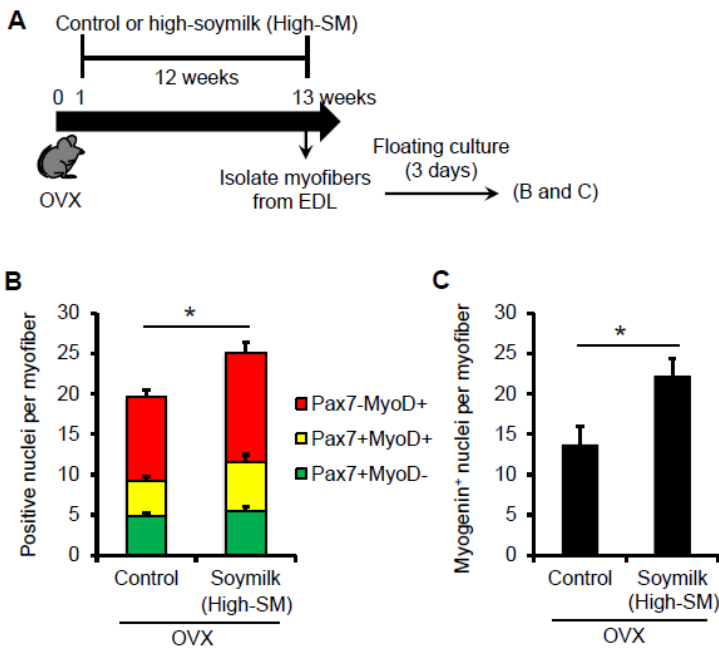
Figure 5. Effect of High ‐ SM intake on satellite cell function in OVX mice. ( A ) OVX mice were fed with High ‐ SM as shown in Figure 3. Satellite cells retained in their niche on myofibers were isolated from the extensor digitorum longus (EDL) muscle in OVX mice, cultured in mitogen ‐ rich medium for 72 h, and co ‐ immunostained for Pax7 and MyoD. Number of Pax7 + and/or MyoD + ( B ) or Myogenin + ( C ) nuclei per myofibre was quantified. (more than 20 myofibers per mouse were counted; control, n = 5; soymilk, n = 4 mice). Data represent the mean ± SEM. n.s., not significant. An asterisk denotes a significant difference from control ( * p < 0.05).